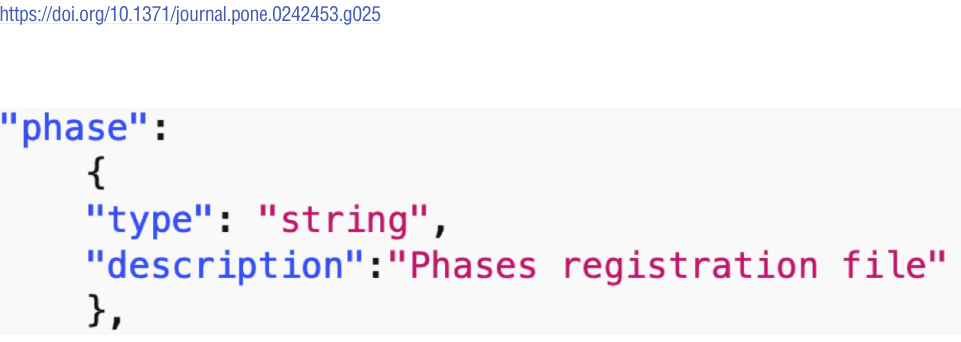
Fig 26. To run a pipeline (called a job), a configuration input file specifies functions and their order of execution. This Figure shows a portion of the schema for a configuration file that specifies the phase JSON schema file location.